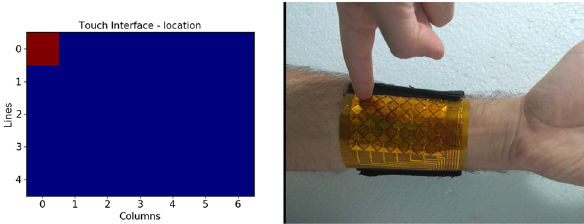
Figure 13: Touch detection on one point at the fi rst electrode.